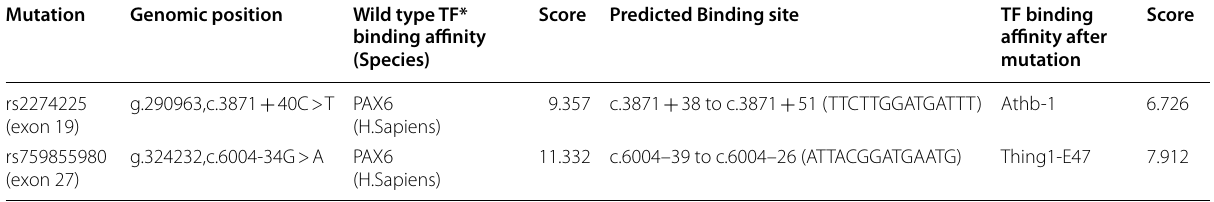
Table 6 Consite server results elucidate the effect of SNP on gene regulation